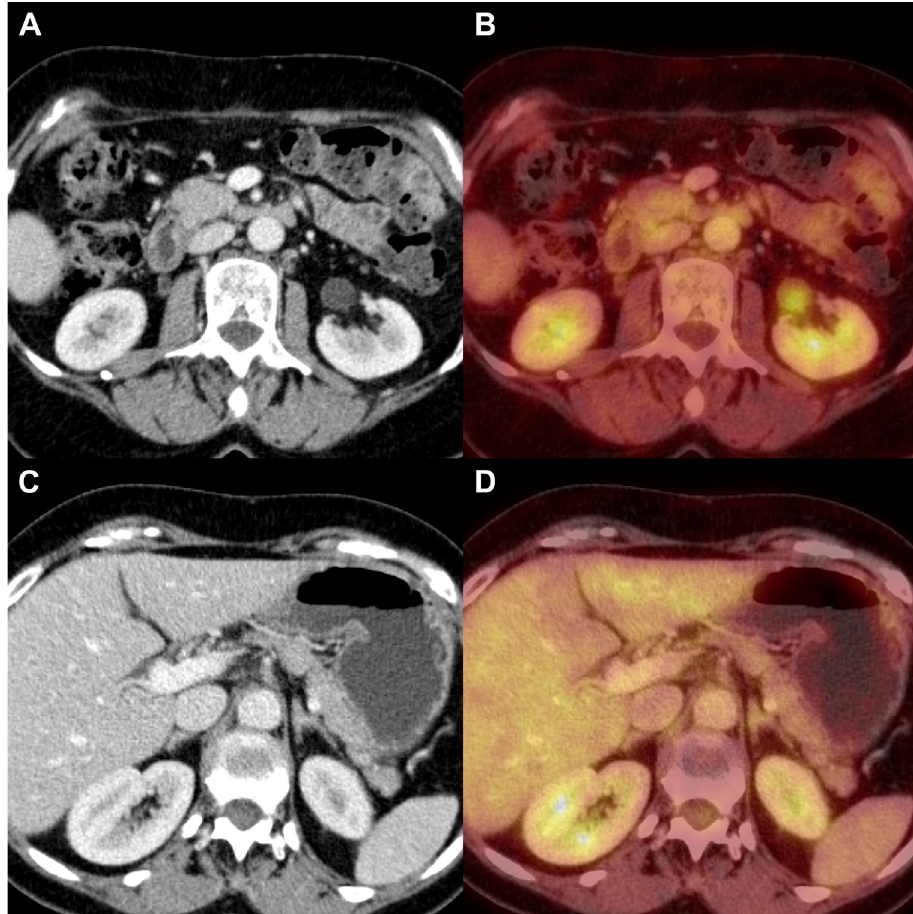
Fig. 5A. CT scan after treatment - normal duodenum wall thickness 5B. PET/CT fusion after treatment - normal FDG uptake in the duodenum wall 5C. CT scan after treatment – no obvious enlargement of liver hilum lymph node 5D. PET/CT fusion after treatment - no FDG uptake in liver hilum lymph